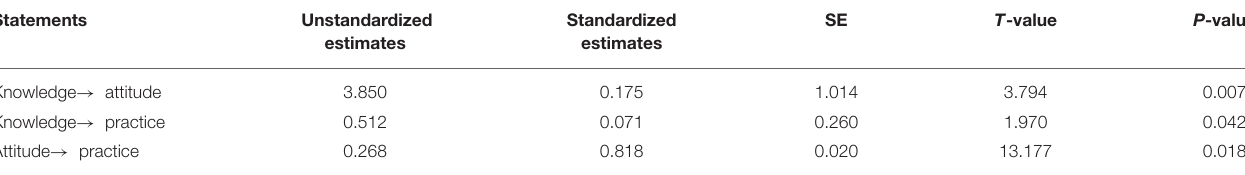
TABLE 5 | Hypothesis testing results for path coefficients of knowledge, attitude and practice.